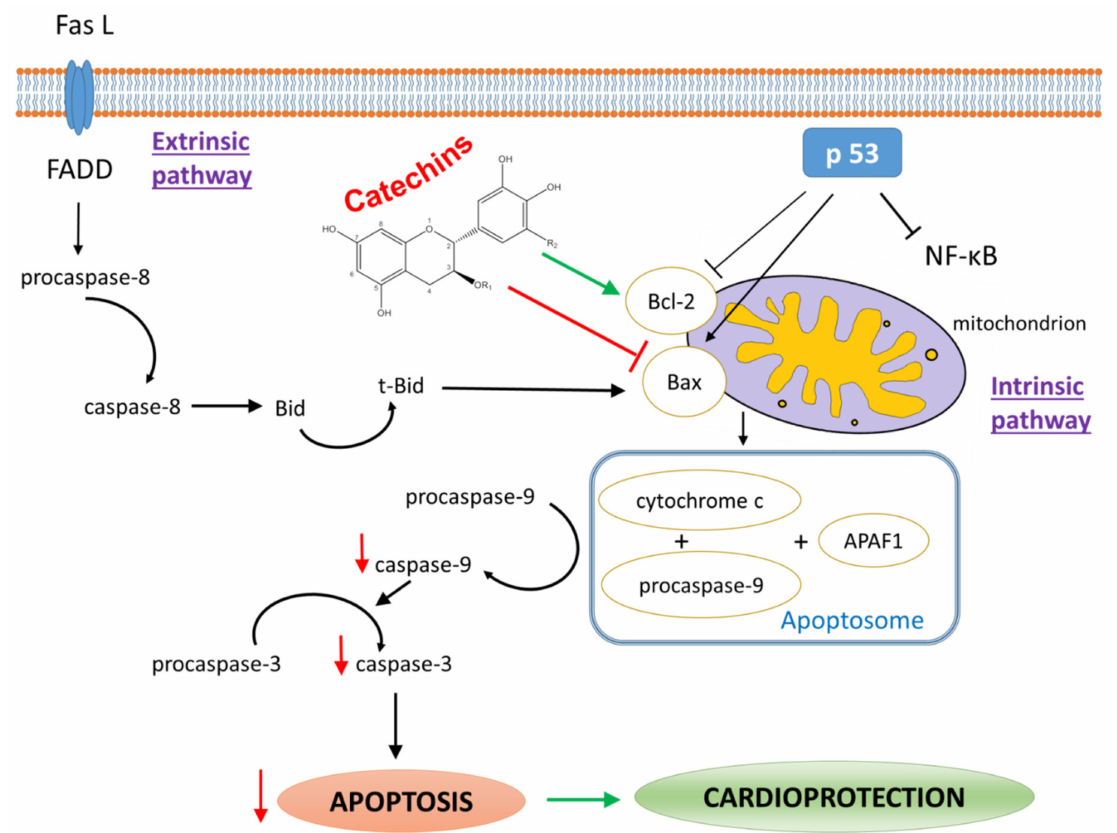
Figure 3. Anti-apoptotic effects of catechins in myocardial I/R injury. Catechins affect several proteins of apoptotic pathways; particularly, they inhibit p53 and enhance Bcl-2/Bax ratio, resulting in reduced caspase-3 activation, thus, reducing apoptosis rate in cardiomyocytes, finally, leading to cardioprotection. Abbreviations: FADD, Fas-associated protein with death domain; NF-kB, nuclear factor kappa-light-chain-enhancer of activated B cells; APAF1, apoptotic protease activating factor 1; Fas L, Fas ligand; tBid, truncated form of Bid; Bid, BH 3 -only